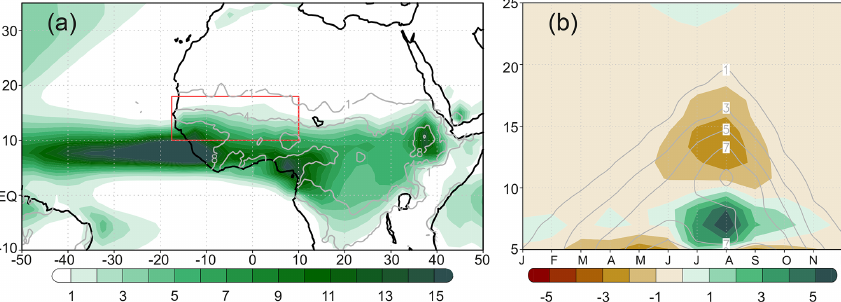
Figure 3. Climatological bias of simulated monthly precipitation. (a) JAS mean averaged across (colors) the 2000-year piControl run and (contours) the 1891–2019 period in the GPCCv2020 observational database. (b) Meridional seasonal cycle (colors) of the 10 ◦ W–10 ◦ E mean model bias (simulation minus observations) compared to (contours) the GPCPv2020 climatology. All units are millimeters per day. Red box in (a) indicates the Sahel region (10–18 ◦ N, 17.5 ◦ W–10 ◦